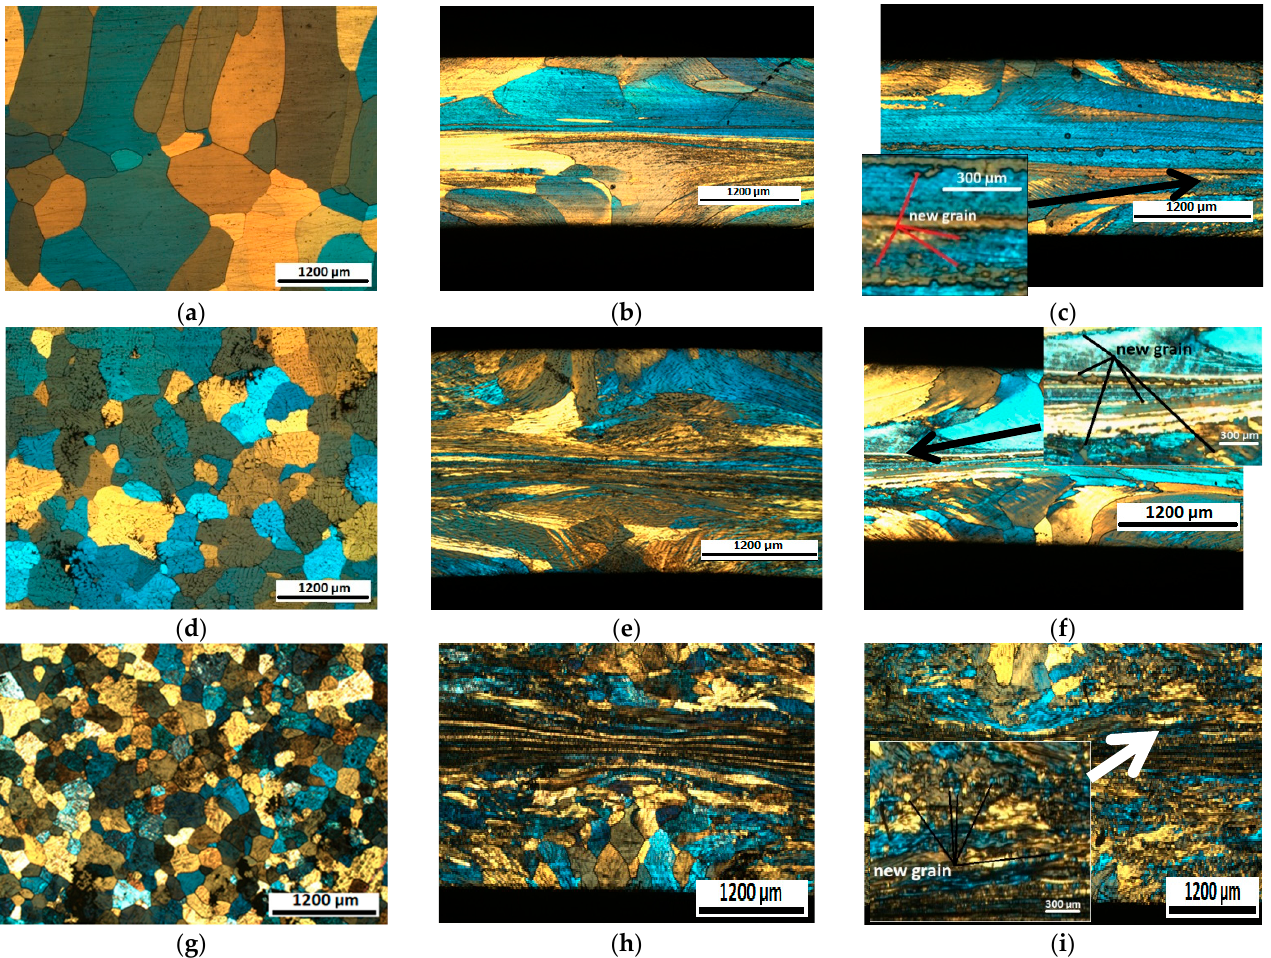
Figure 2. Grain structure of three alloys, 80% hot deformed in plain-strain condition at different strain rates and temperatures: ( a – c ) Al-95 alloy: ( a ) as-cast state, ( b ) 80%, strain rate 1 s − 1 , 300 ◦ C ( c ) 80%, strain rate 1 s − 1 , 450 ◦ C; ( d – f ) AlMg1 alloy: ( d ) as-cast state, ( e ) 80%, strain rate 1 s − 1 , 300 ◦ C, ( f ) 80% strain rate 1 s − 1 , 450 ◦ C; ( g – i ) AlMg4 alloy: ( g ) as-cast state, ( h ) 80%, strain rate 1 s − 1 , 450 ° С , ( i ) 80%, strain rate 10 s –1 , 450 °C.